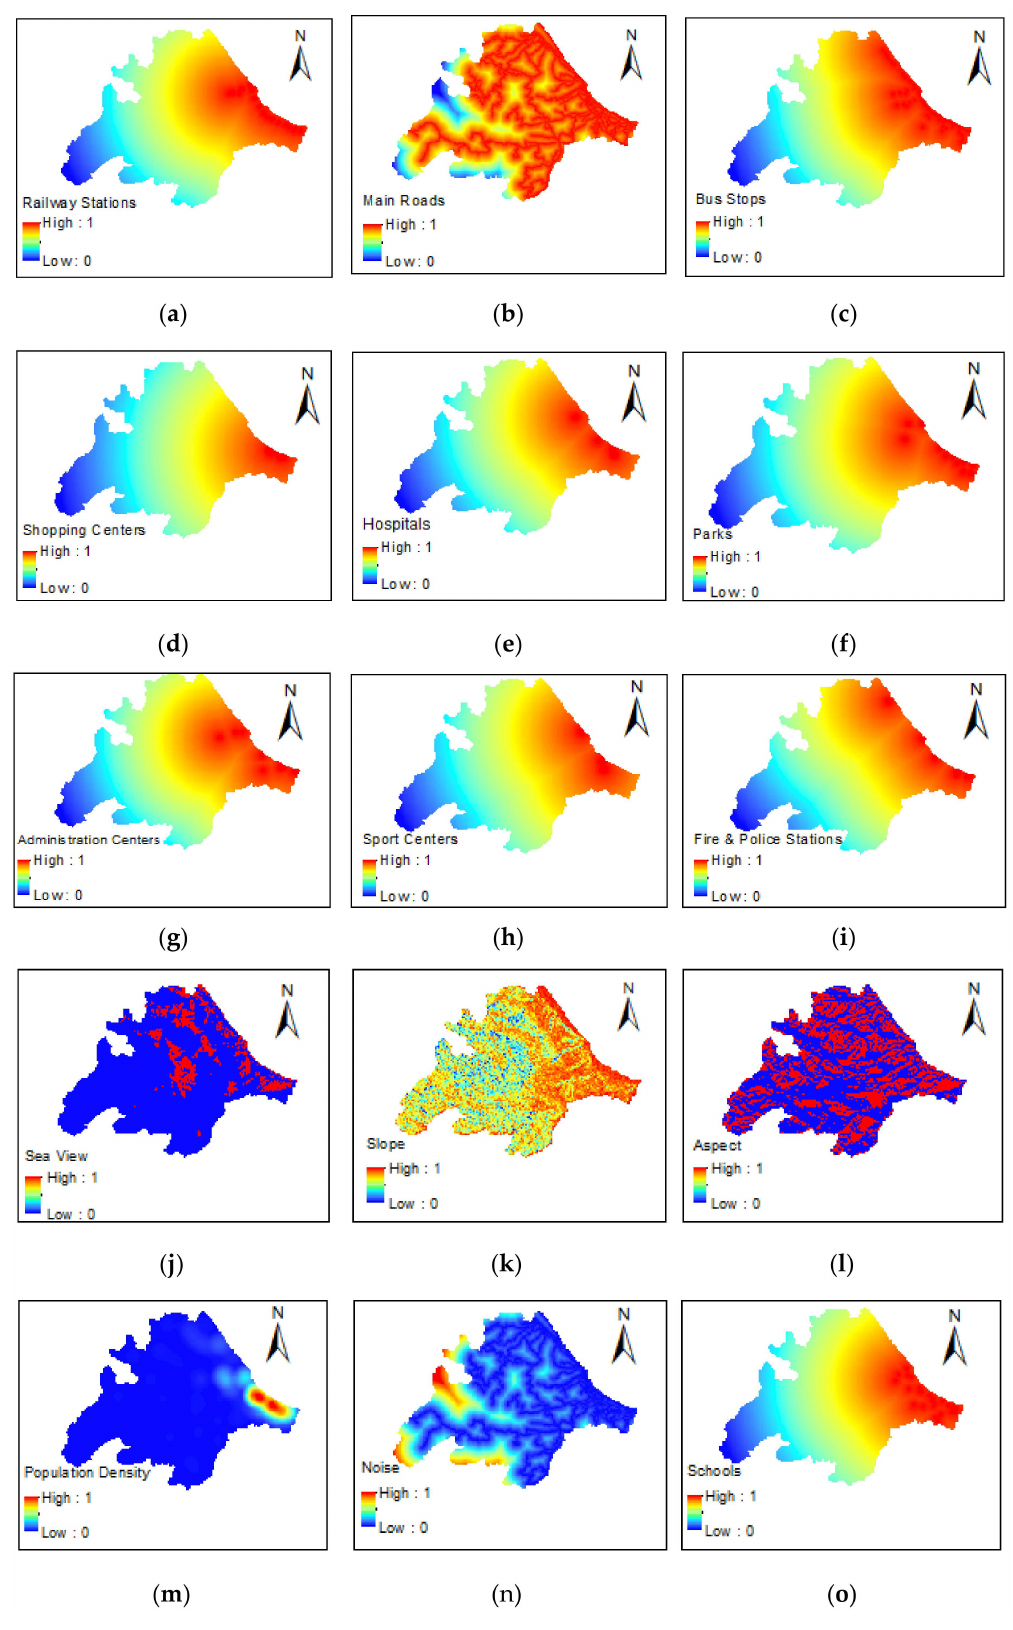
Figure 4. Normalized criteria maps, ( a ) railway stations, ( b ) main roads, ( c ) bus stops, ( d ) shopping centers, ( e ) hospitals, ( f ) parks, ( g ) administration centers, ( h ) sport centers, ( i ) fire and police stations, ( j ) sea view, ( k ) slope ( l ) aspect, ( m ) population density, ( n ) noise, and ( o )